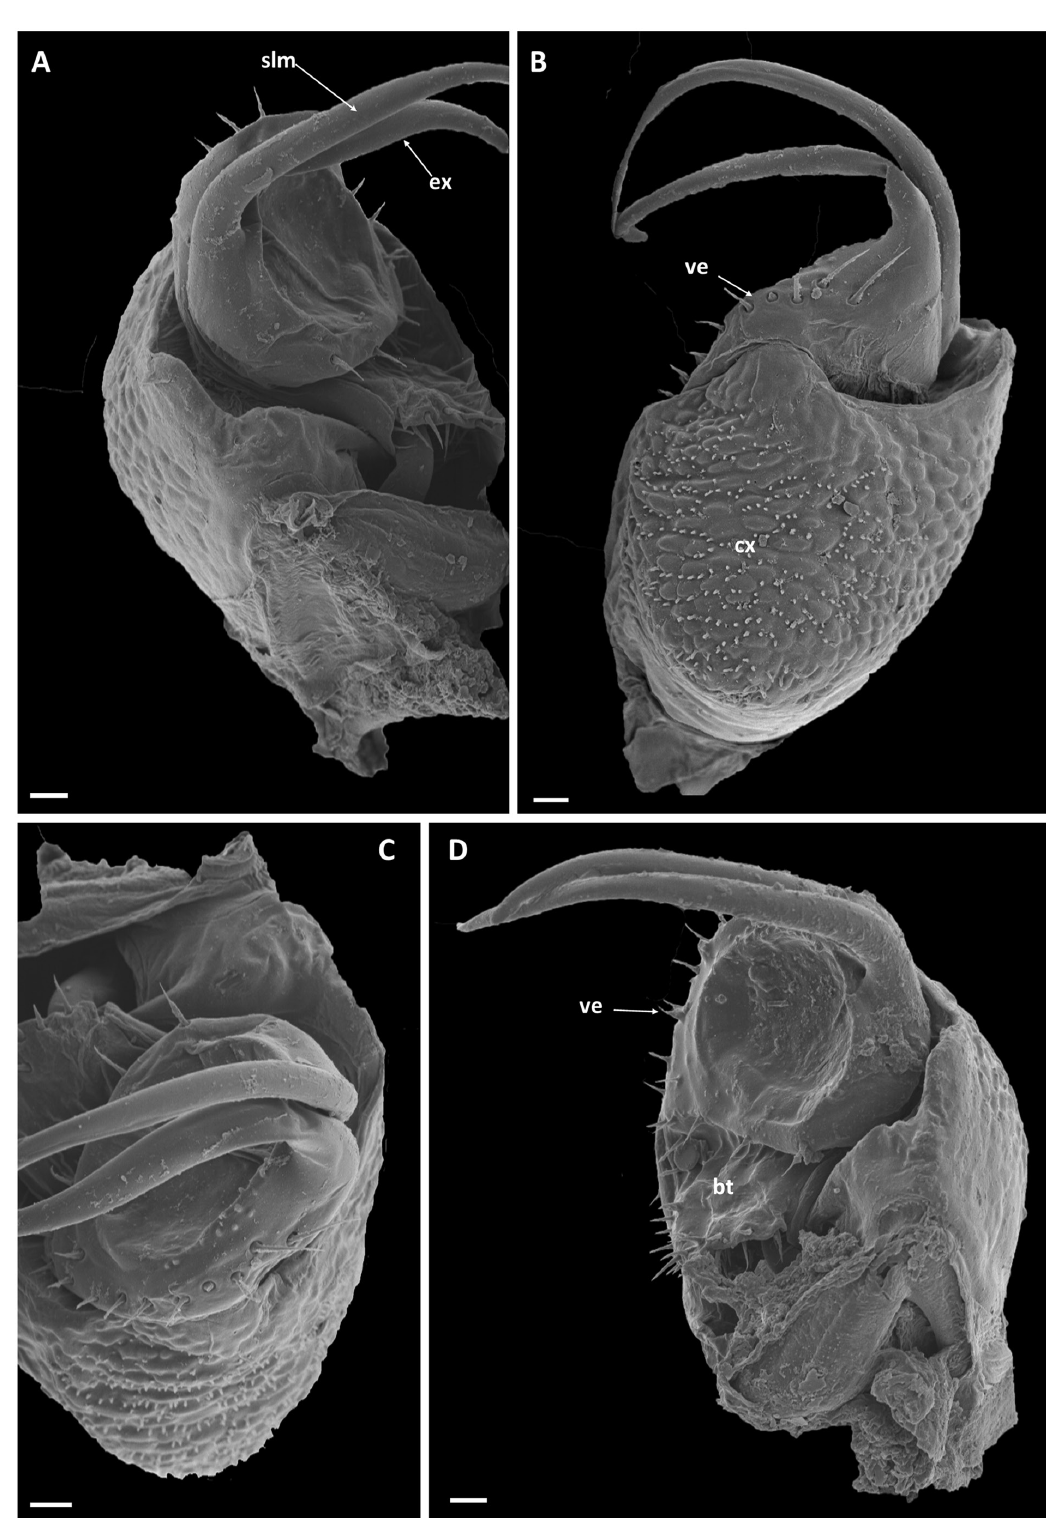
Fig. 6. Cryptocorypha geminiramus sp. nov., paratype (NHMD 621824), ♂, from Kidatu. A–C . Left gonopod. A . (Sub)mesal view. B . Lateral view. C . (Sub)ventral view. D . Right gonopod, Posterio-mesal view. Abbreviations: bt = basal part of telopodite; cx = coxa; ex = exomere; slm = solenomere; ve = velum(?). Scale bars = 0.01